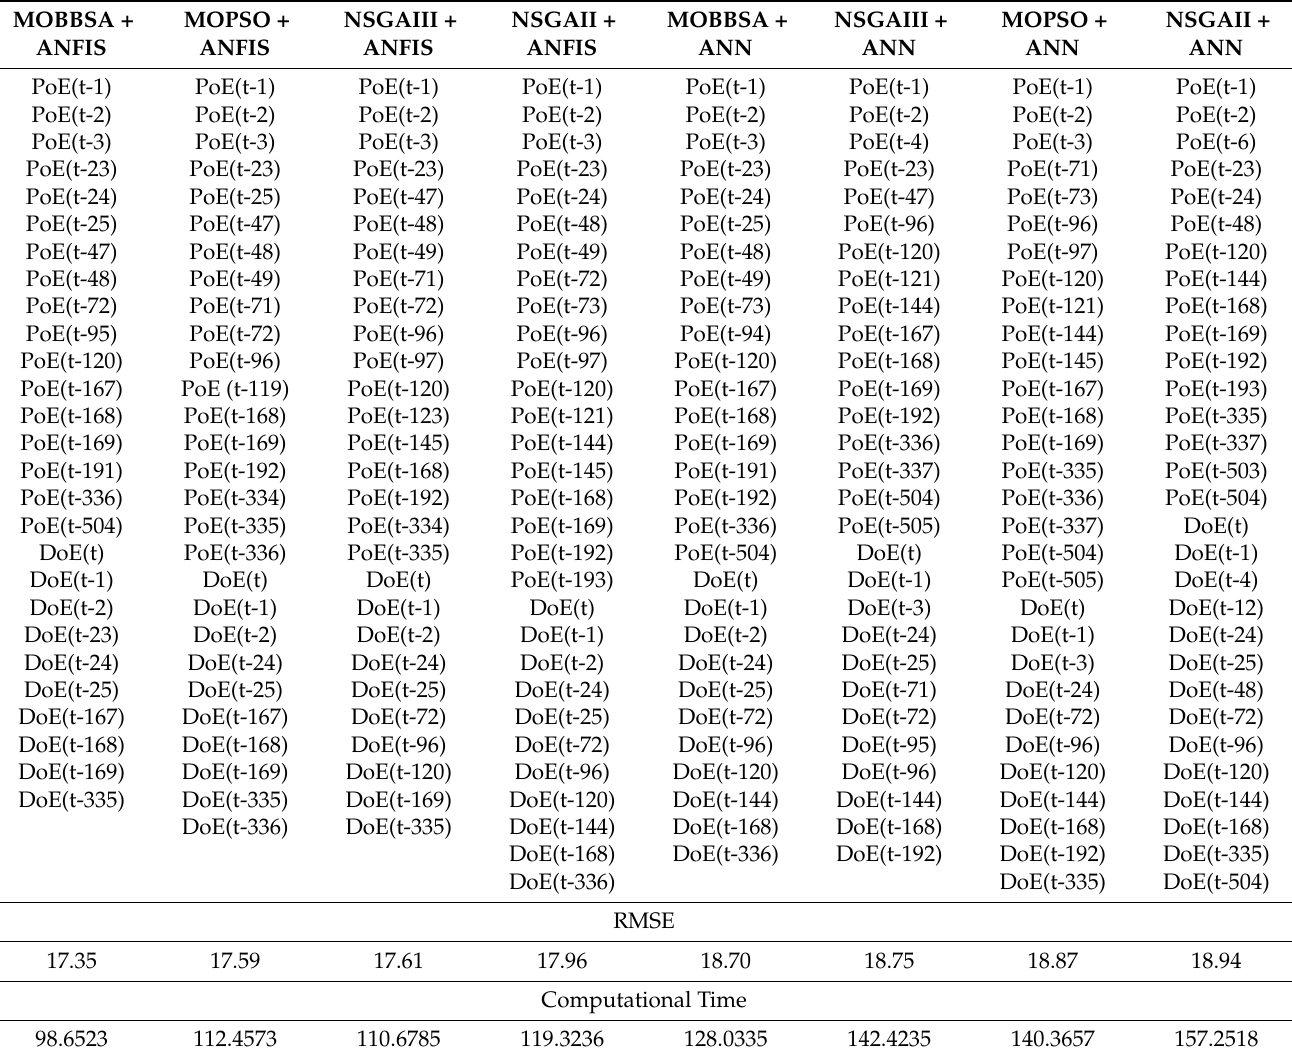
Table 2. The multi-objective feature selection methods select the optimal subsets of input variables by studied, RMSE and computational time value, which represent their subsequent performances.